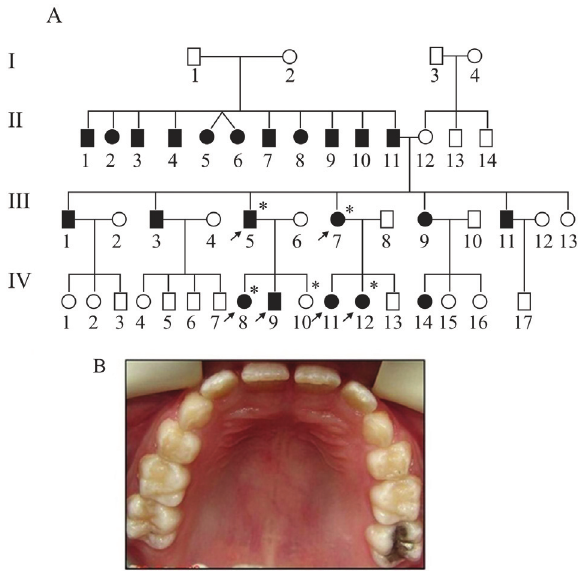
Figure 3 - Family 3. A. The pedigree indicated autosomal dominant inher- itance with 22 affected members (black symbols). The arrows show the proband patients who were attended in this study and the asterisks indicate individuals who were analyzed clinically and whose ENAM gene was se- quenced. B. Photograph of proband IV:8. The AI phenotype in this family was classified as hypomaturative (snow capped) with characteristics simi- lartofluorosis.Grooveswithwhitestainsthatvariedinlocationandinten- sity were observed among different members of the family. These alter- ations were observed mainly in the cuspids.